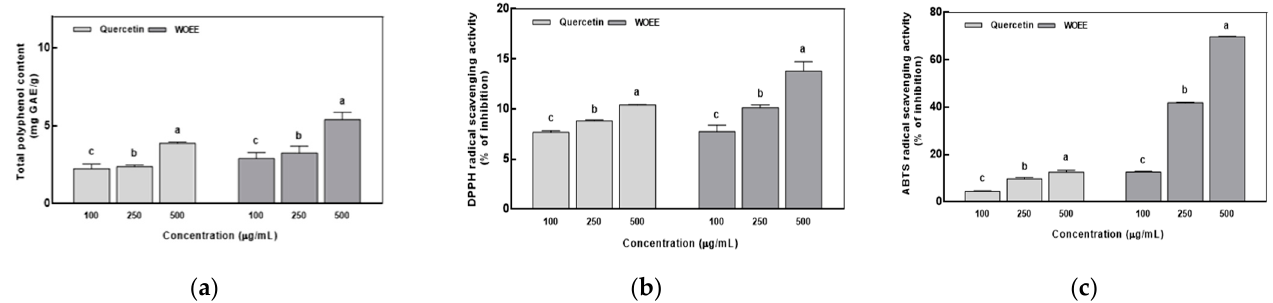
Figure 1. Antioxidant effects of quercetin and WOEE. ( a ) Total polyphenol content, ( b ) DPPH radical scavenging activity, and ( c ) ABTS radical scavenging activity. The data were analyzed by one-way ANOVA using SPSS software and each bar presents the mean ± SE. (n = 3). a–c Mean values with different letters are significantly different ( p < 0.05) among groups, determined by Duncan’s multiple range test.